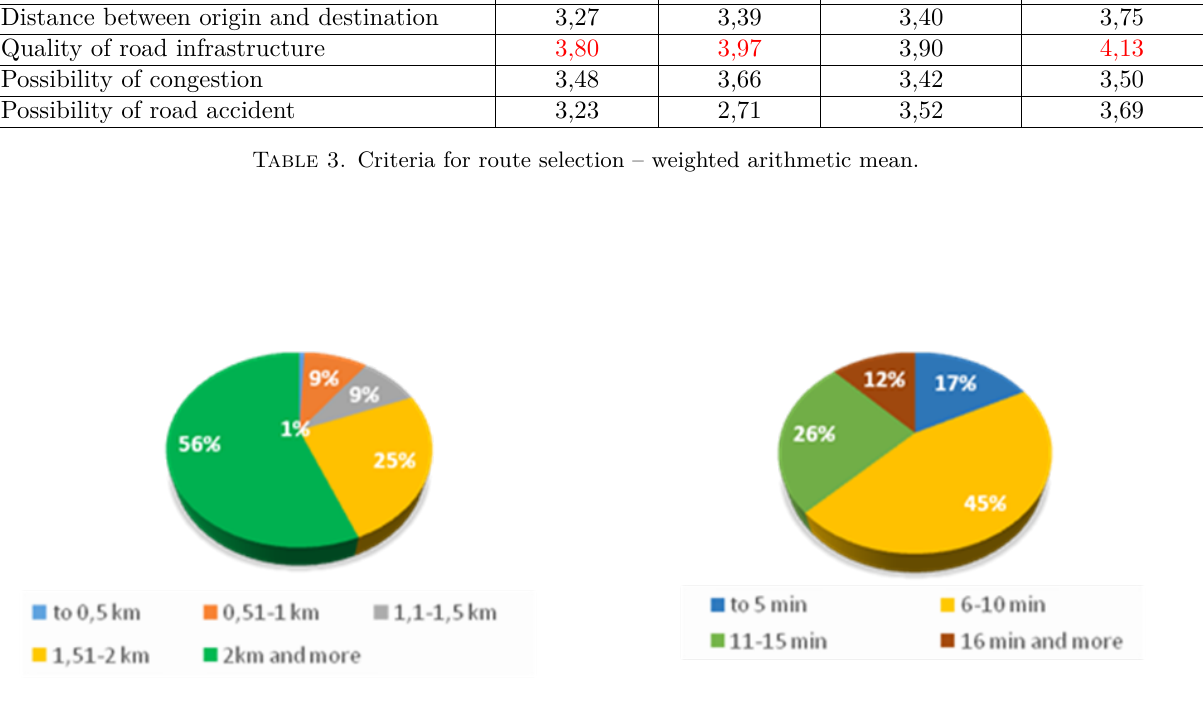
Figure 5. Acceptability of alternative route due to the length of detour (left) and with respect to the prolongation of travel time